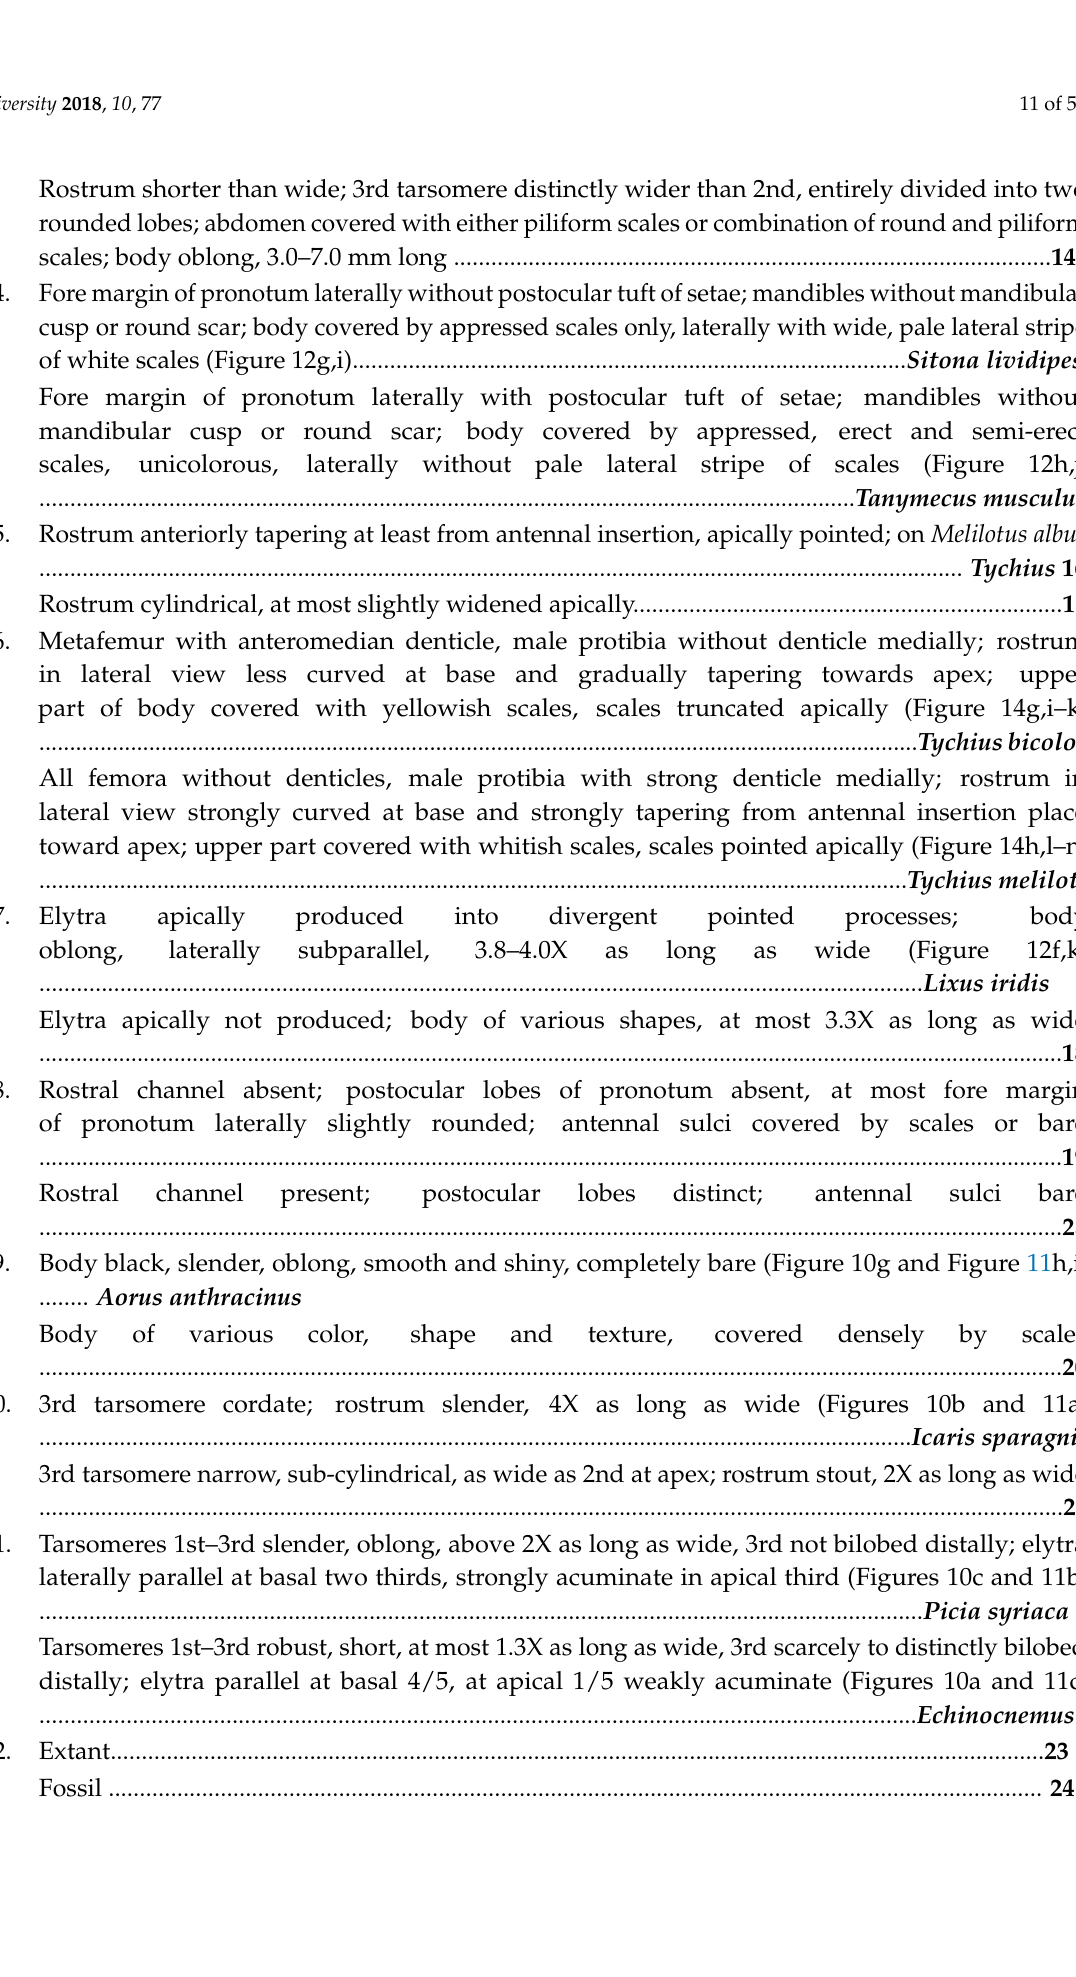
- distally; elytra parallel at basal 4/5, at apical 1/5 weakly acuminate (Figures 10a and